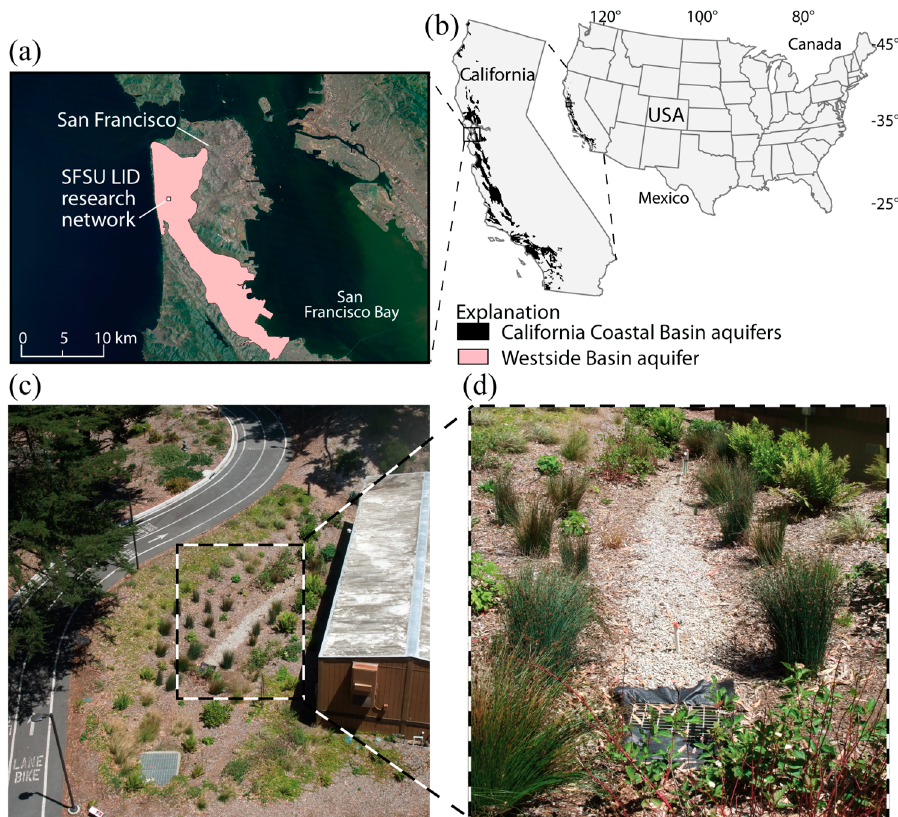
Figure 1. ( a ) Map showing the location of the San Francisco State University (SFSU) low impact development (LID) research network; and ( b ) the Westside Basin aquifer, which is part of the California Coastal Basin aquifers. The aquifer location data are modified from the California Department of Water Resources and the U.S. Geological Survey. Photographs of the infiltration trench from: ( c ) aerial view; and ( d ) zoomed ‐ in view are modified from Newcomer et al. 2014 [27].